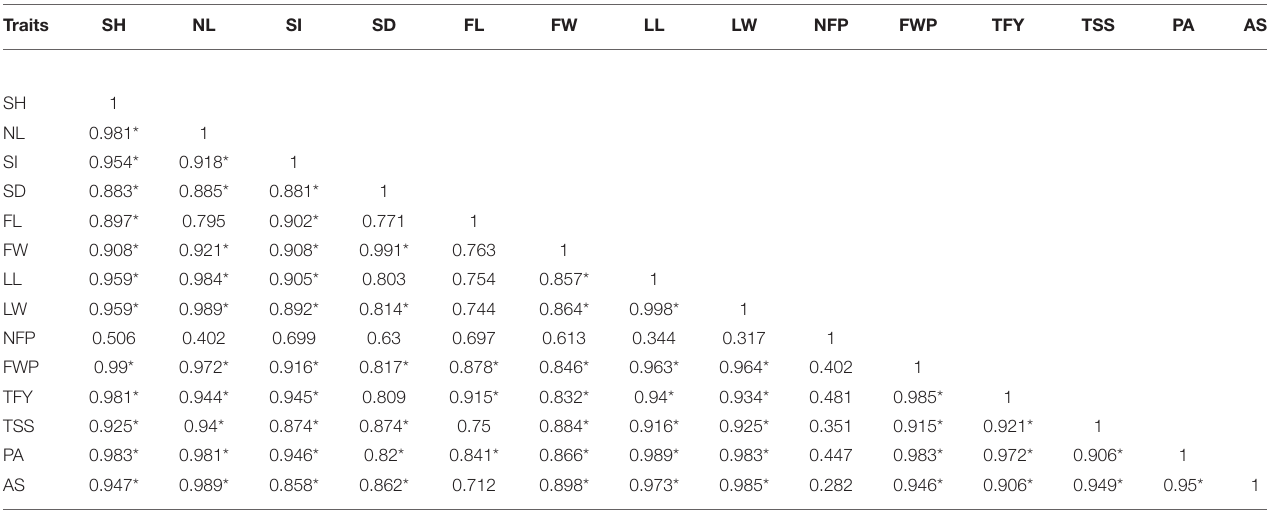
TABLE 3 | Pearson’s correlation coefficient of plant vegetative growth factors, biochemical parameter, yield and its components, phenolic compound, and ascorbic acid contents of bell pepper ( Capsicum annuum L.) foliar sprayed with cyanobacteria ( Roholtiella sp.) HVPE and WRB under hydroponic systems. Traits SH NL SI SD FL FW LL LW NFP FWP TFY TSS PA